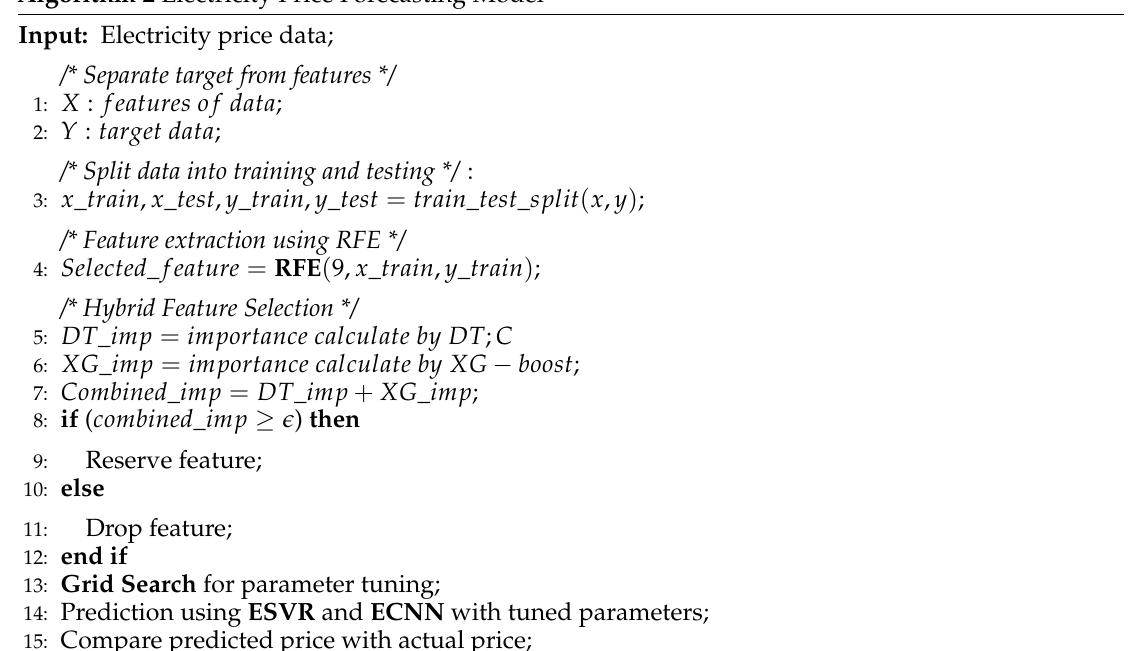
Algorithm 2 Electricity Price Forecasting